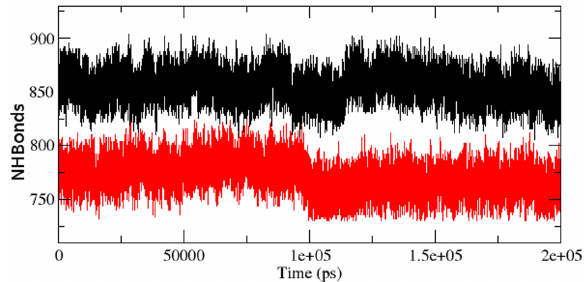
Figure 8. Average number of protein–solvent intermolecular hydrogen bonds in native and mutant Aurora-A protein versus time at 300 K. Native is shown in black and mutant in red.